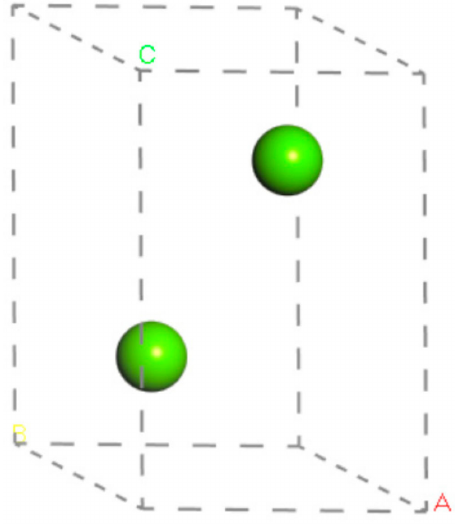
Figure 1. Mg lattice